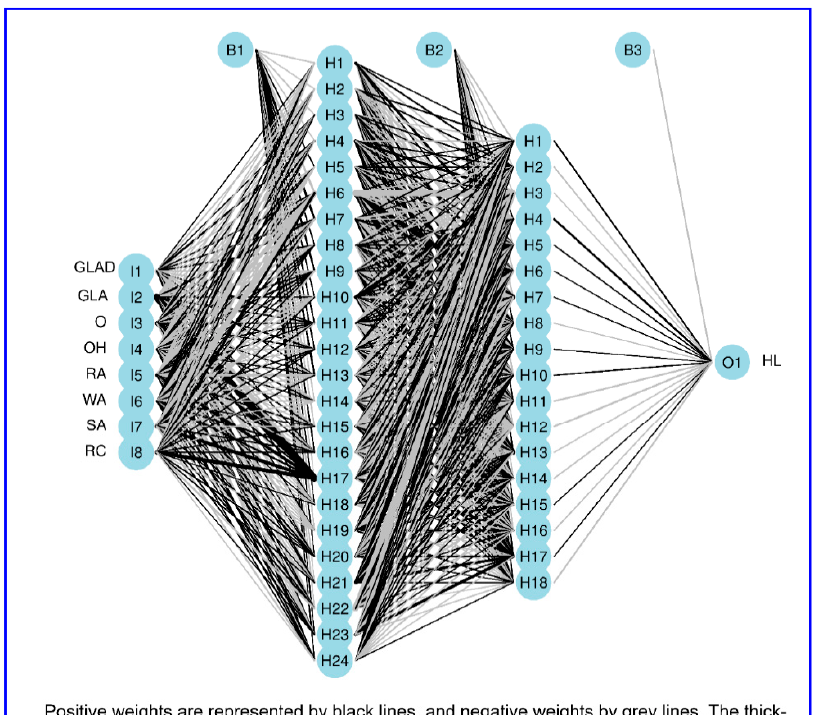
Figure 7. Structure of the GA-ANN model for determining HL of EEB systems.